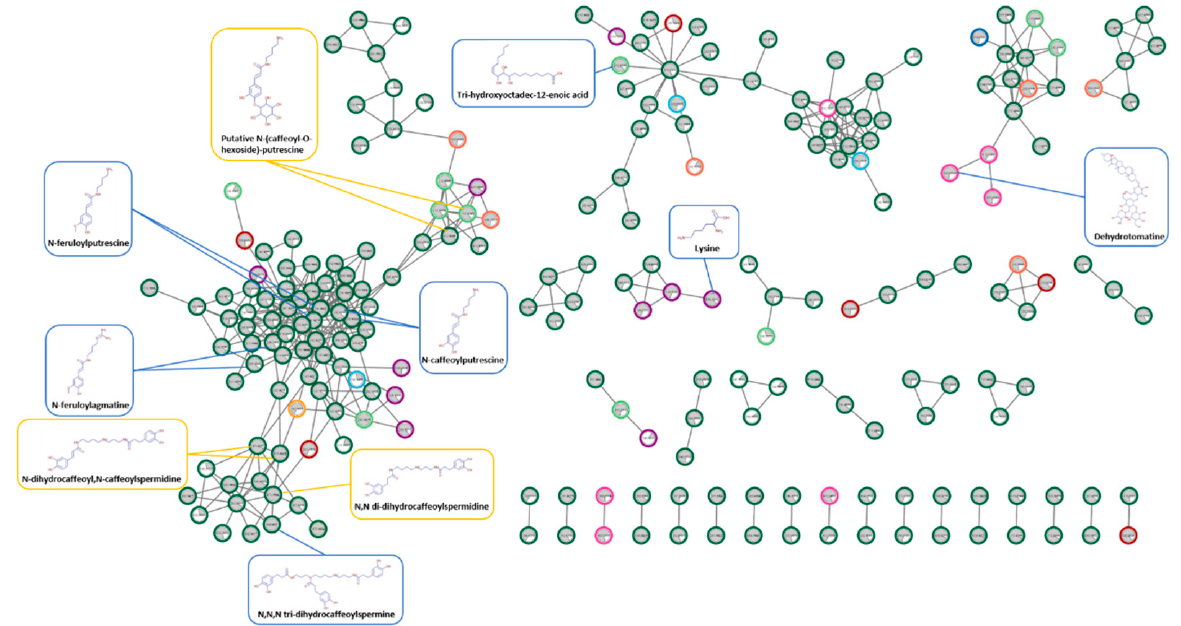
Figure 2. Molecular network of up- and down-regulated features in the tomato organs in response to T. absoluta herbivory. The molecular network was obtained using Compound Discoverer 3.3 and was visualized with Cytoscape 3.9.1 following the procedure described at https://github.com/Florent-1/Molecular-Networks-from-Compound-Discoverer-to-Cytoscape (accessed on 10 April 2022). The pie chart in each node represent the relative abundance of the feature in T.absoluta treated (grey) vs. control (white). These abundances are presented in priority in InfLat 4 days of herbivory, identified by a dark green circle surrounding the node. When the feature is not affected in InfL, the relative abundance is represented for the most impacted organ, with the following nomenclature: Light green, InfL at 7 days; purple: St at 4 days; pink, St at 7 days; dark blue, LowL at 4 days; light blue, LowL at 7 days; red, R at 4 days; orange, R at 7 days. The structures of some formally identified nodes are surrounded in blue, and those of putative compounds are surrounded in yellow.